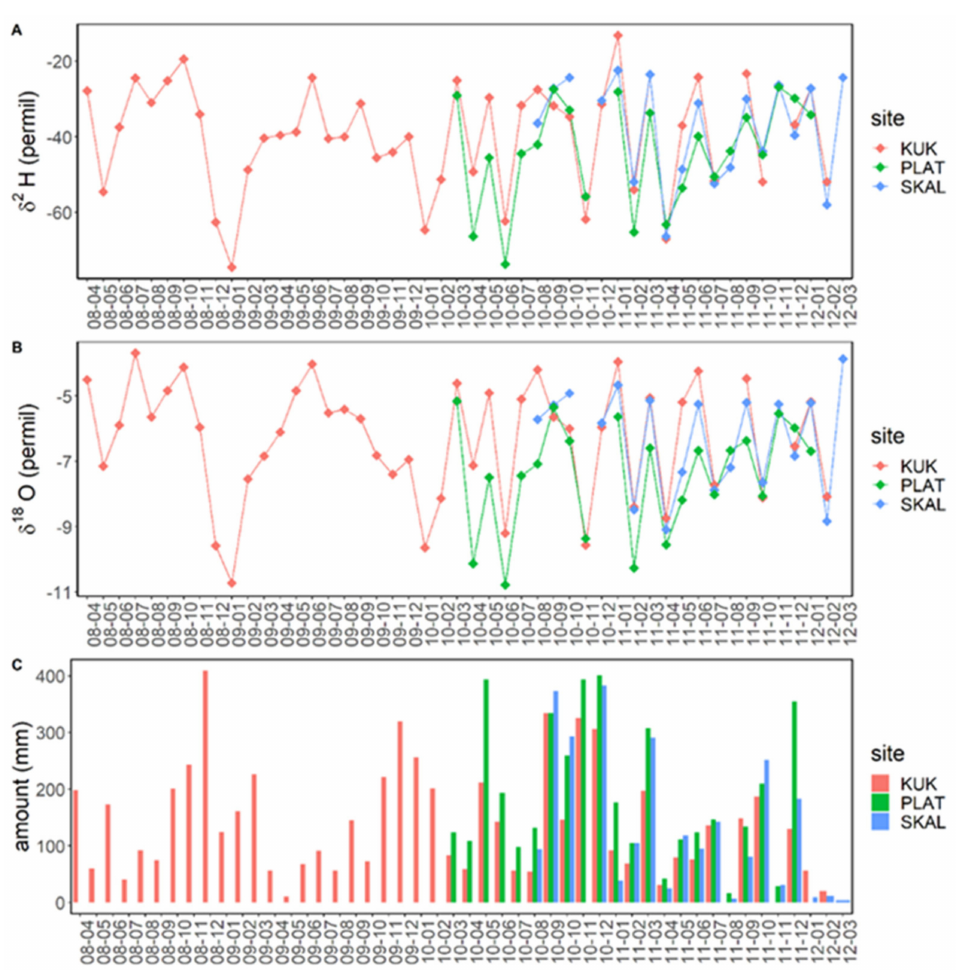
Figure 5. ( A ) δ 2 H values, ( B ) δ 18 O values, and ( C ) amount of monthly precipitation of cumulative monthly precipitation samples at Kukuljanovo (KUK), Platak (PLAT) and Škalnica (SKAL) rain gauging